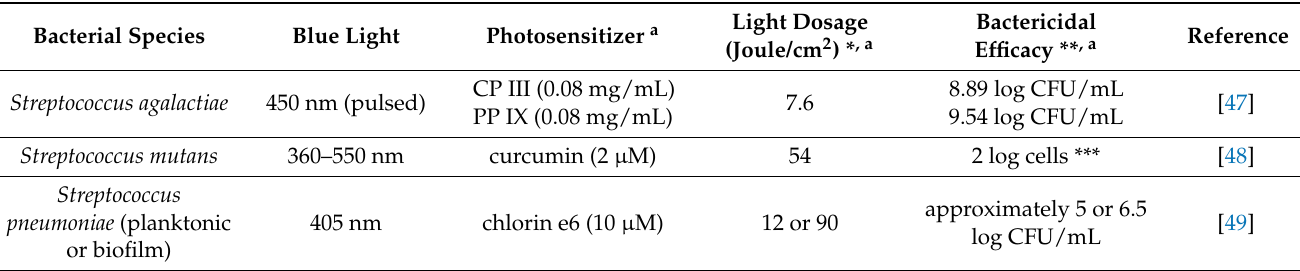
Table 1. Selected in vitro studies on photodynamic treatment of heme non-producing bacterial species. Bacterial